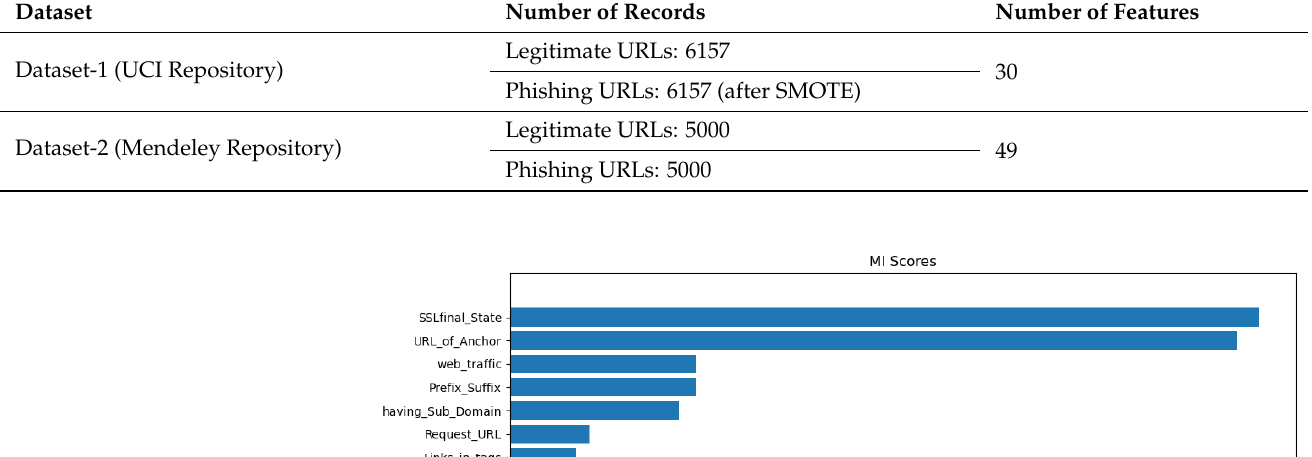
Table 13. Experiment dataset for feature selection.